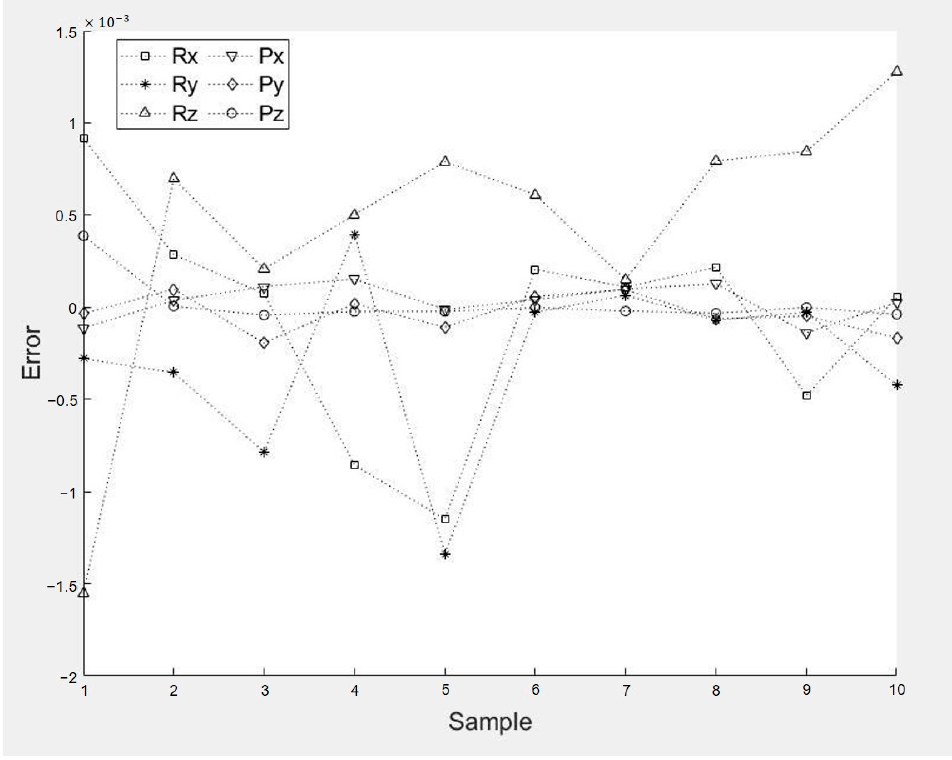
Figure 8. MPR-NR positive solution